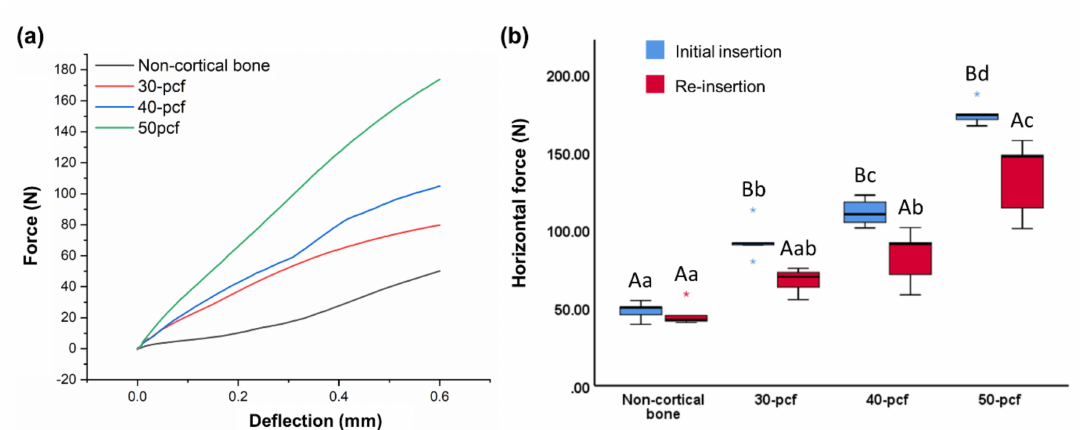
Figure 6. Horizontal resistance as ( a ) horizontal force versus deflection distance and ( b ) horizontal force at 0.6 mm deflection. Di ff erent uppercase letters indicate a significant di ff erence between the initial insertion and re-insertion ( P < 0.05). Di ff erent lowercase letters indicate a significant di ff erence between the various cortical bone densities ( P < 0.05).